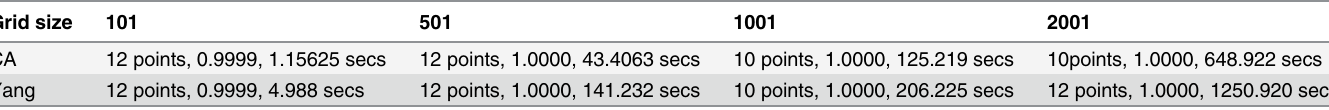
Table 3. Number of support points in the generated designs from the Cocktail and Optimal Weights Exchange algorithms using different grid sizes, their relative D -efficiencies and CPU times for the model in Eq (15). Grid